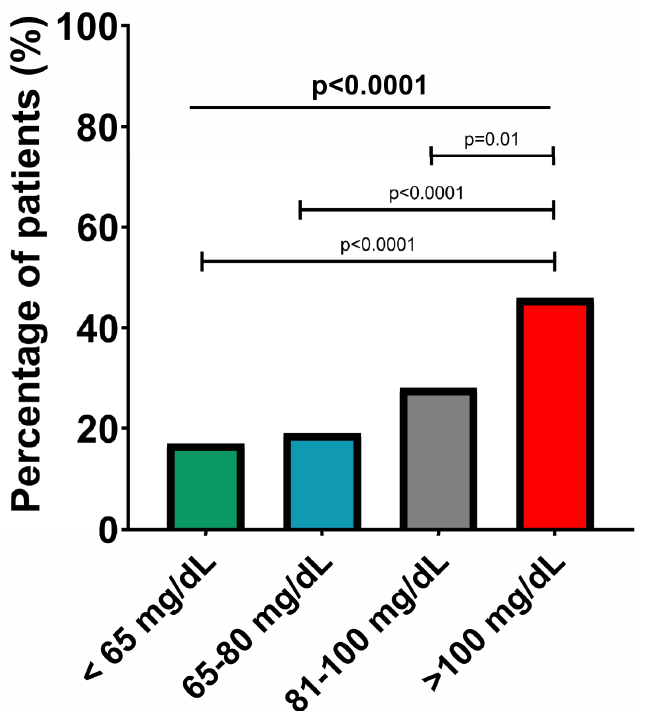
Figure 4. Presence of significant carotid plaques in the Apo B risk subgroups. The values are expressed as percentages; p -values refer to between-group comparisons based on a chi-squared test. Table 3. Lipid profile in the Apo B risk